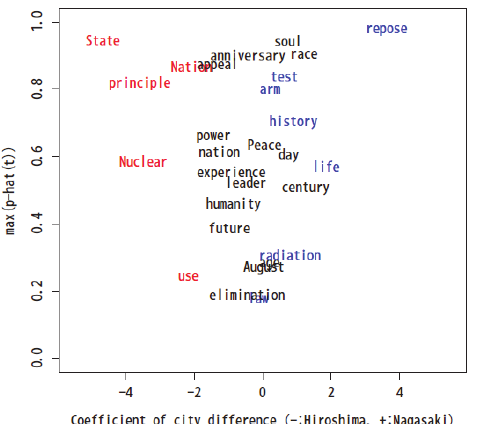
Fig. 17. Estimates and 95% simultaneous CI of regression coefficient in "age"